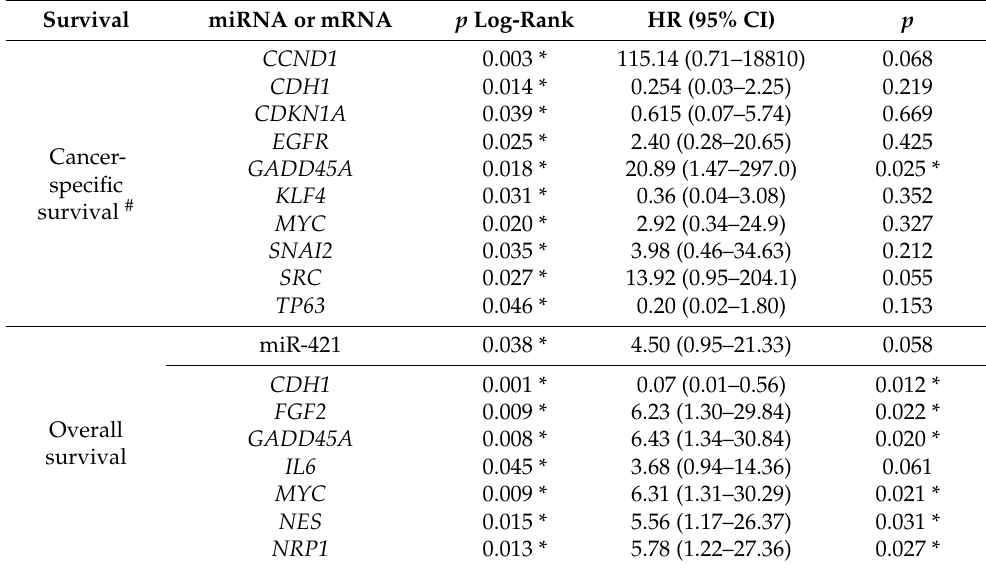
Table 4. Cancer-specific and overall survival when comparing high and low expression levels of miRNAs and